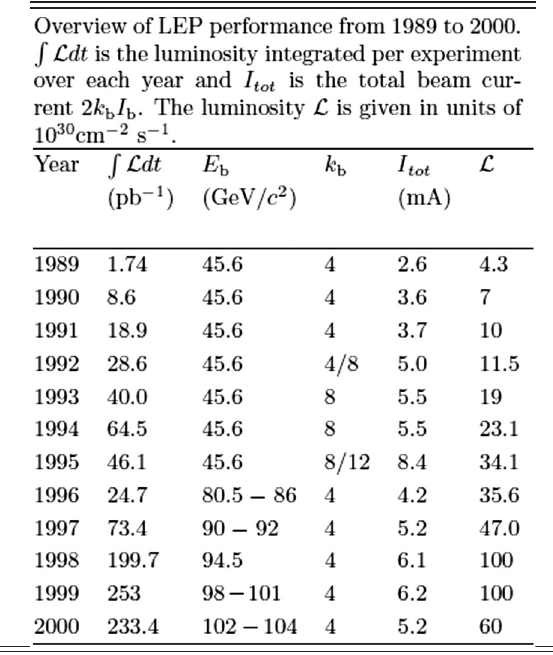
TABLE II. Overview of LEP performance from 1989 to 2000. Note E b is the energy per beam, k b the number of bunches per beam and L is the peak luminosity.